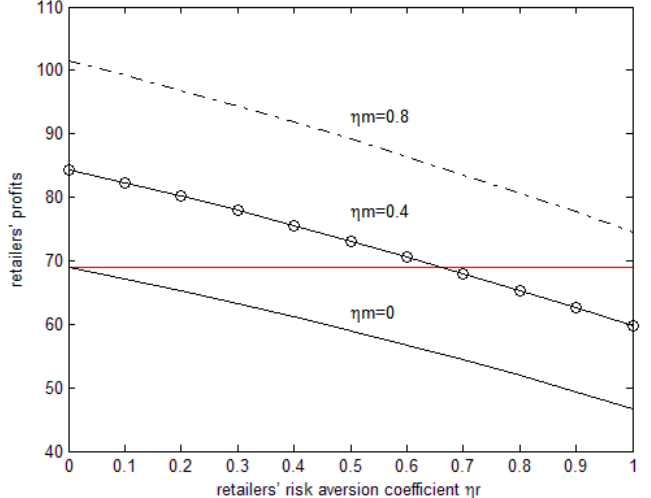
Figure 5. The effects of the risk aversion coefficient on the retailer’s profits.